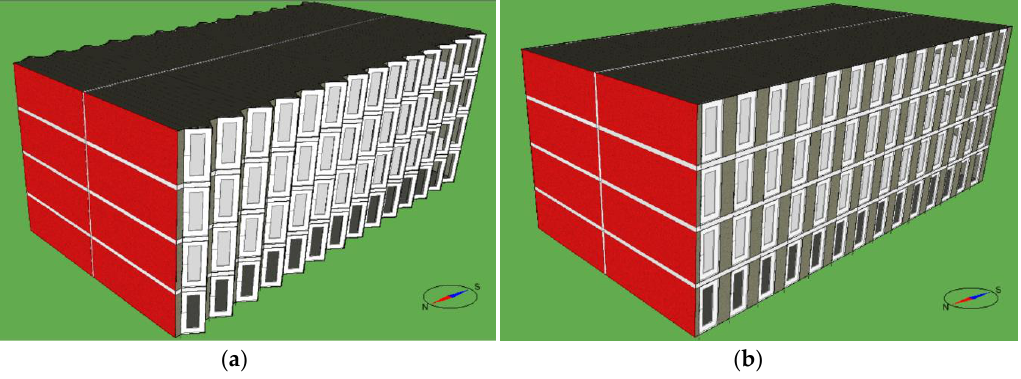
Figure 1. ( a ) The studied model with an angled façade and ( b ) the studied model with a straight façade. For both models, the reference surface is the short side without windows, directed to the north (in the standard case) and marked with red in the